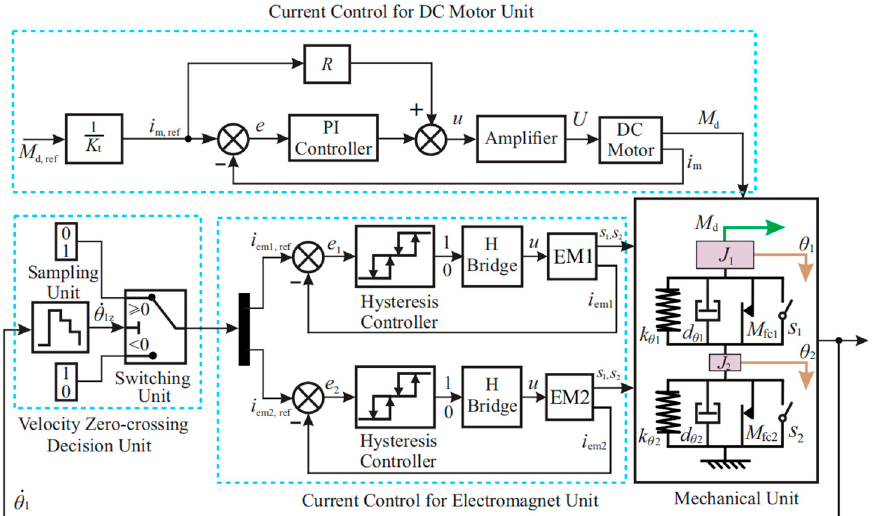
Figure 4. Schematic for the control.